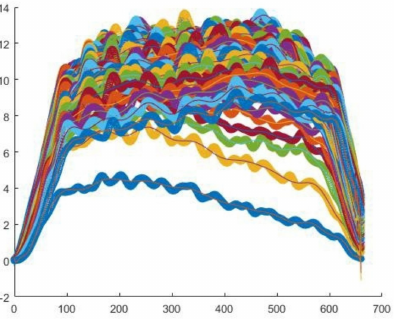
Figure 17. Energy integration results along the y-axis on the illuminated surface.